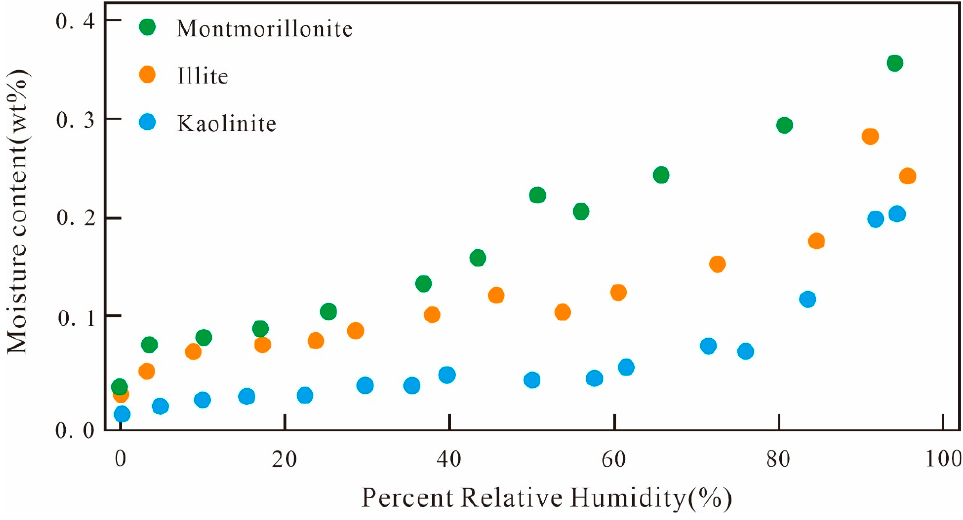
Figure 7. Water adsorption capacities of different types of clay minerals under different humidity conditions (modified from [108]).